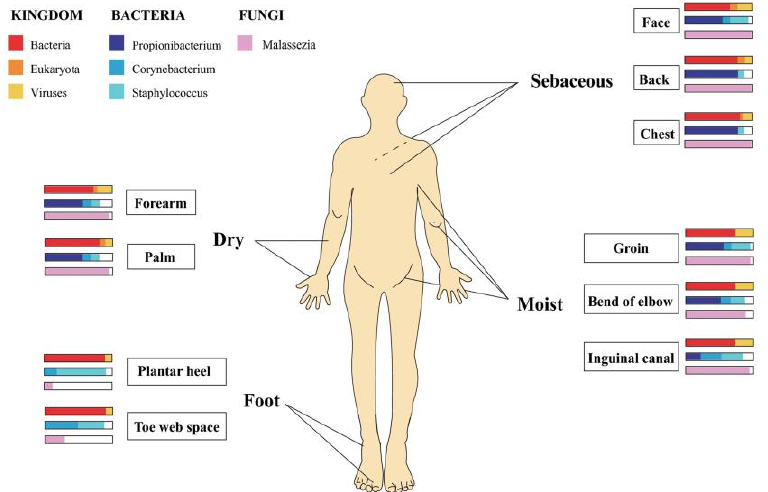
Figure 5. Regional distribution of microorganisms in human skin. Dry (forearm and palm), sebaceous (head, back, and chest), moist (groin, bend of elbow, and inguinal canal), and foot (plantar heel and toe web space). Wide and narrow bar charts represent the anatomical location and relative abundance of microorganisms distributed in those areas. Reproduced with permission from Springer [87].